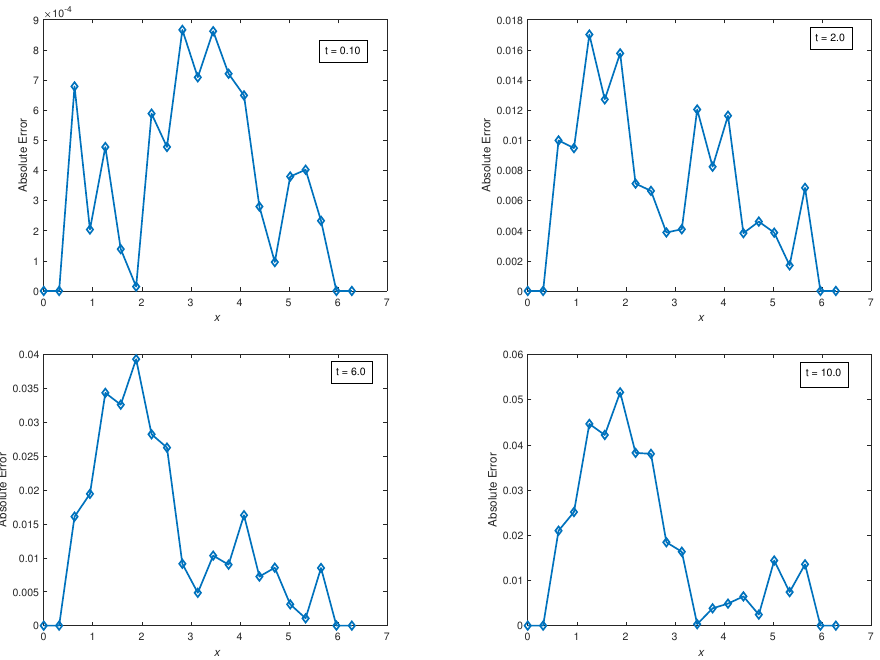
Figure 4. Plots of absolute errors vs. x at times t = 0.10, 2.0, 6.0, 10.0 using a classical finite difference scheme with ∆ t = 10 − 3 and ∆ x =